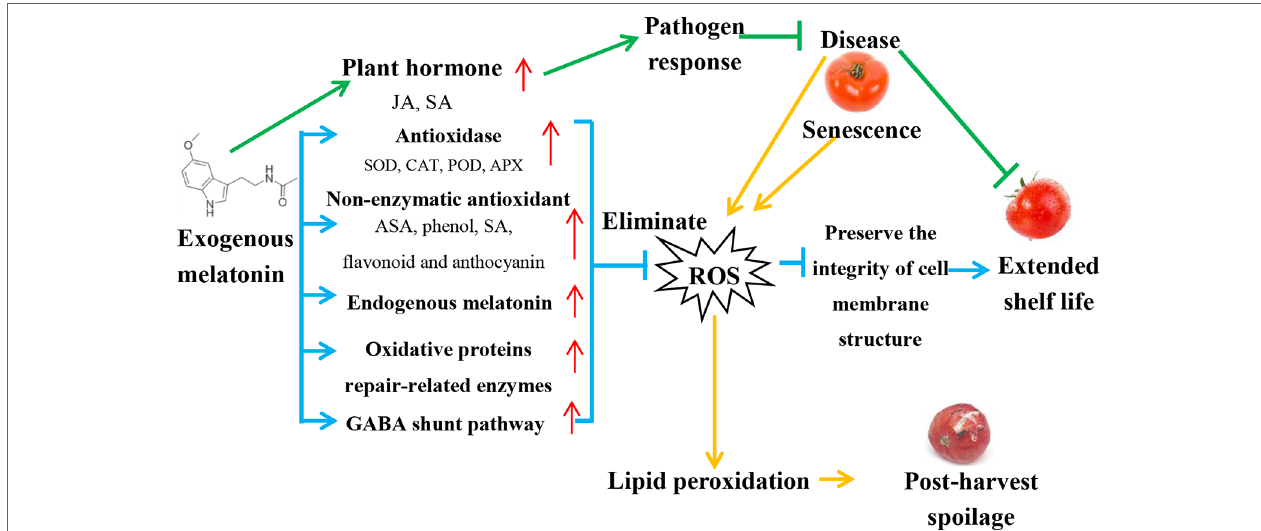
FIGURe 1 | Model of exogenous melatonin-mediated post-harvest preservation mechanism in fruits and vegetables. (1) Blue lines and arrows indicate ROS elimination pathway. Melatonin acts primarily as a powerful free radical scavenger by increasing the content of antioxidant enzymes, non-enzymatic antioxidants, and the enzymes related to oxidative protein repair, removing excess active oxygen from post-harvest fruits and vegetables, and promoting GABA shunt pathway. Subsequently, the content of hydroxyl radicals and hydrogen peroxide decreases, the degree of membrane lipid peroxidation is reduced, thus protecting cells from oxidative damage and prolonging the shelf-life. (2) Green lines and arrows indicate pathogen response dependent pathway. Exogenous melatonin increases the levels of JA and SA, triggers plant pathogen responses, increases pathogen resistance, and extends the shelf life. (3) Orange lines and arrows indicate post-harvest decay of fruits and vegetables. Diseases or senescence of post-harvest fruits and vegetables produce lots of ROS, lead to lipid peroxidation, and cause post- harvest decay. Red arrows indicate increased levels of each component.